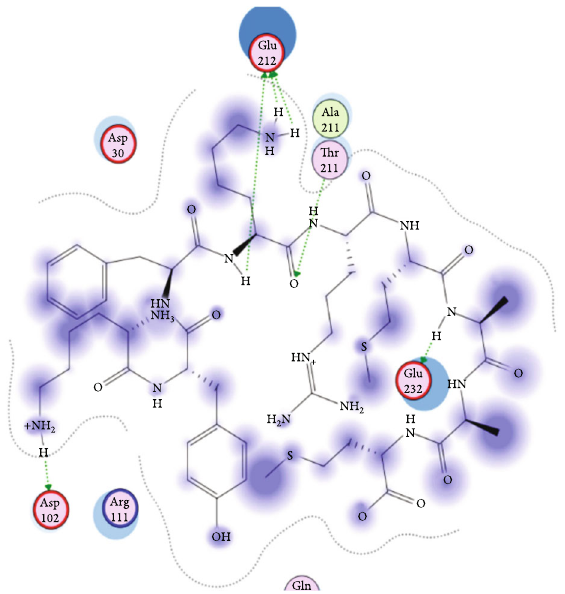
Figure 12: Illustration of the 3D interaction of the best docking poses of KYFKRMAAM in the binding sites of HLA-A ∗